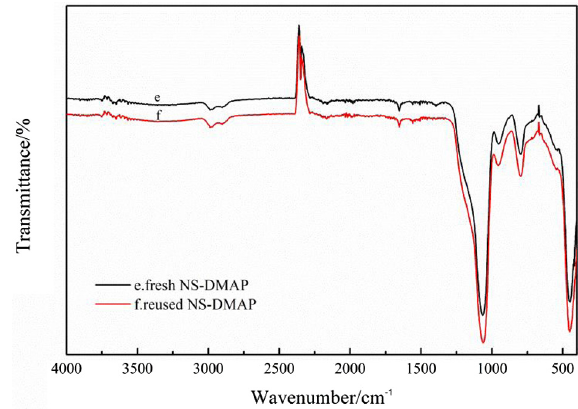
Figure 10: Catalytic recycle times. Conditions of